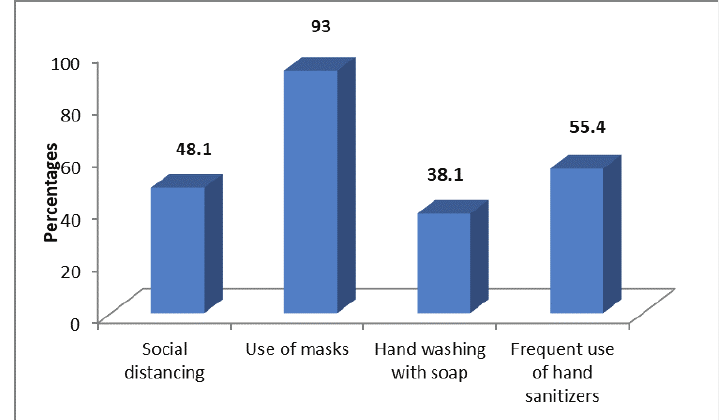
Figure-II: Preventive measures adopted by COVID-19 patients